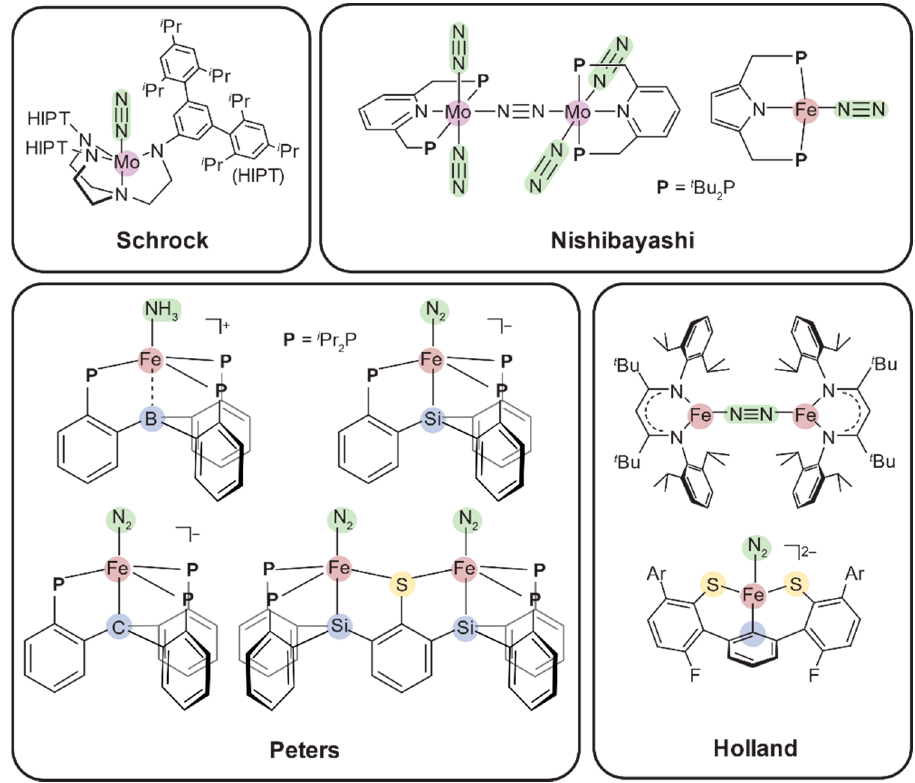
/ or reduction from the 2 activation and